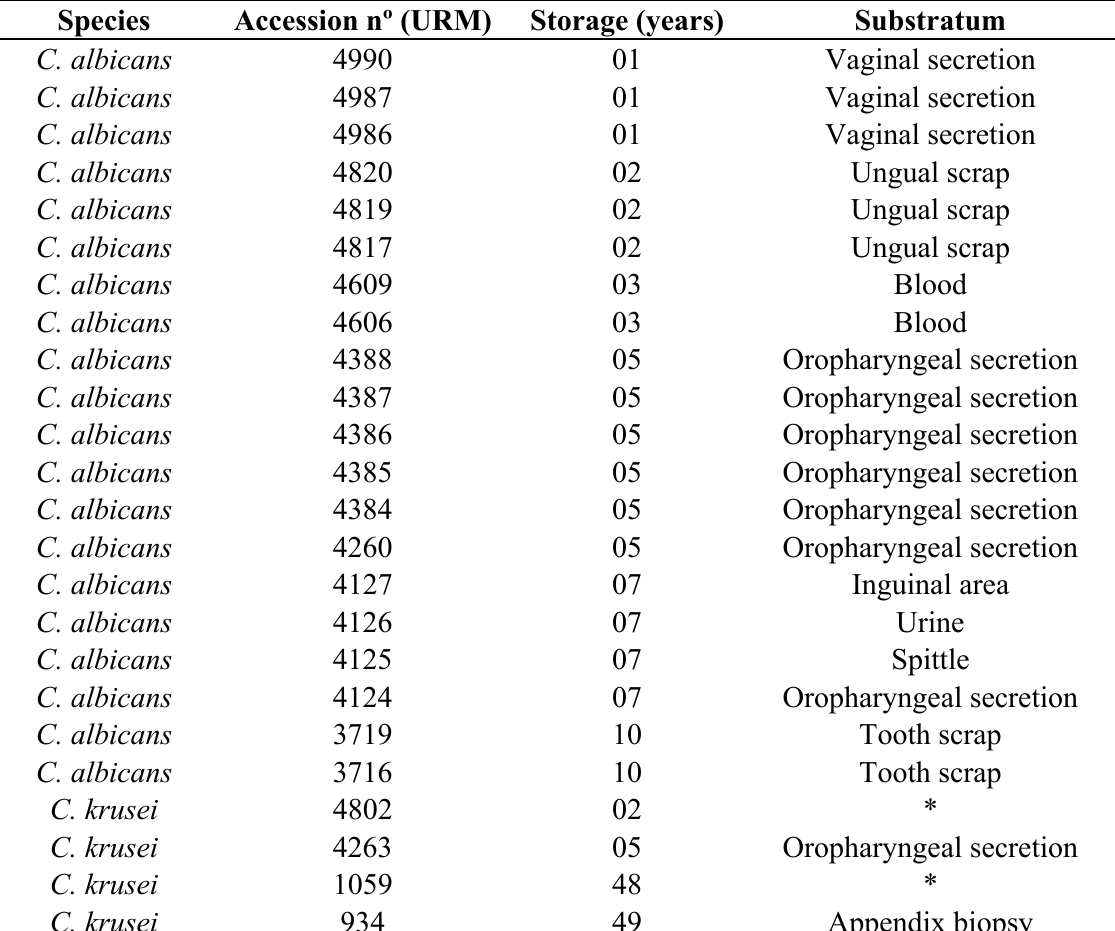
Table 2. Samples of Candida species preserved in the Mycotheca Culture Collection— University of Recife Mycology